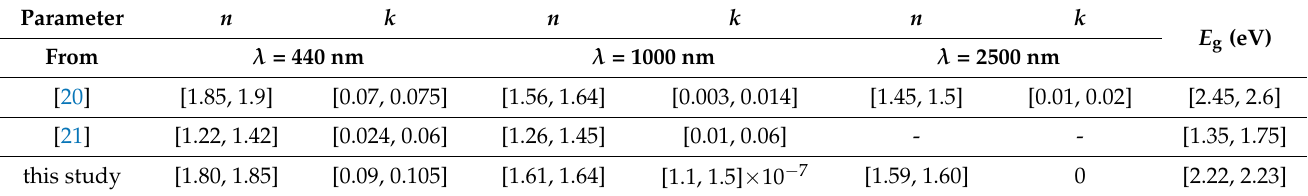
Table 4. Computed optical parameters of PAZO polymer films. The films from [20] have been doped with [1, 5] wt% particles of Cu(II) 3-amino-5,5 (cid:48) -dimethylhydantoin and spin-coated, whereas the films from [21] have been doped with [0, 20] mol% particles of (GeTe 4 ) 100 − x Cu x and electrospray